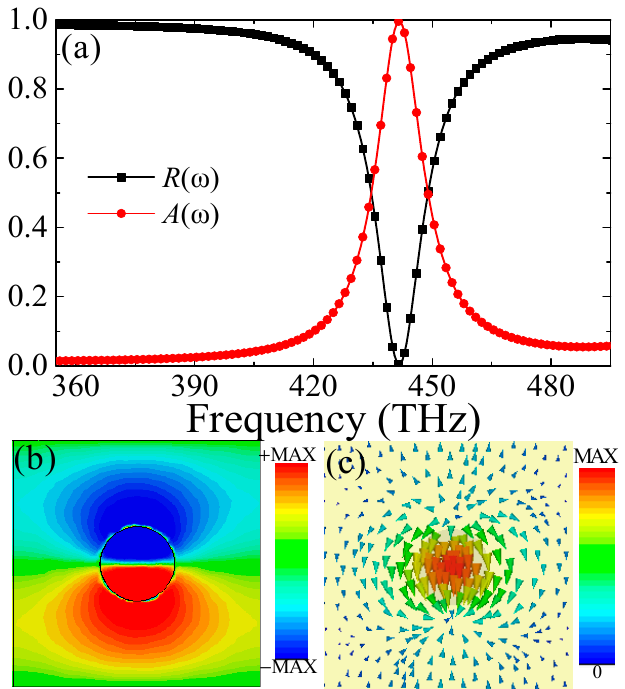
Figure 2. ( a ) The simulated reflectance ( R ( ω )) and absorbance ( A ( ω )) spectra of the single-band PPA, ( b,c ) the distributions of the electric field ( E z in x-y plane) and surface current at 441.5 THz.